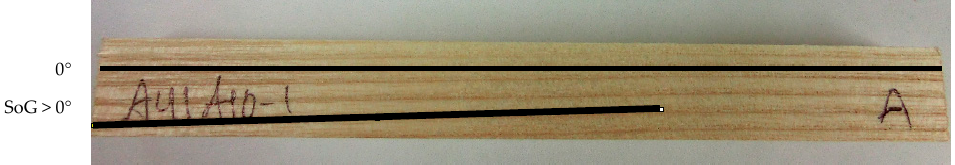
Figure 3. Example of a radial slope-of-grain measurement.